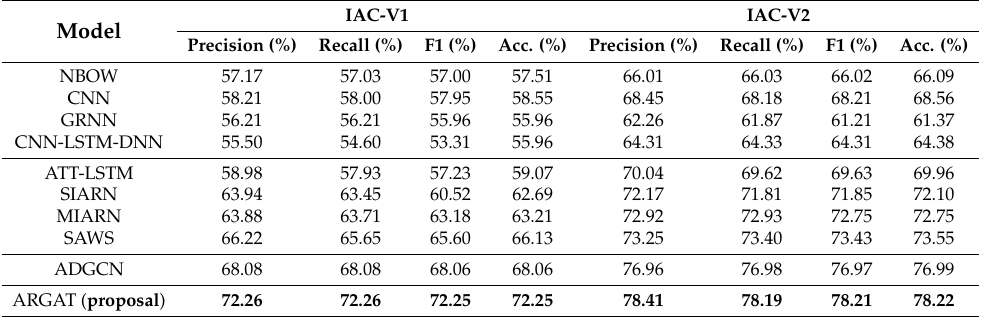
Table 2. Experimental results on IAC datasets. The best results are in bold and the results of four basic models are from [6].